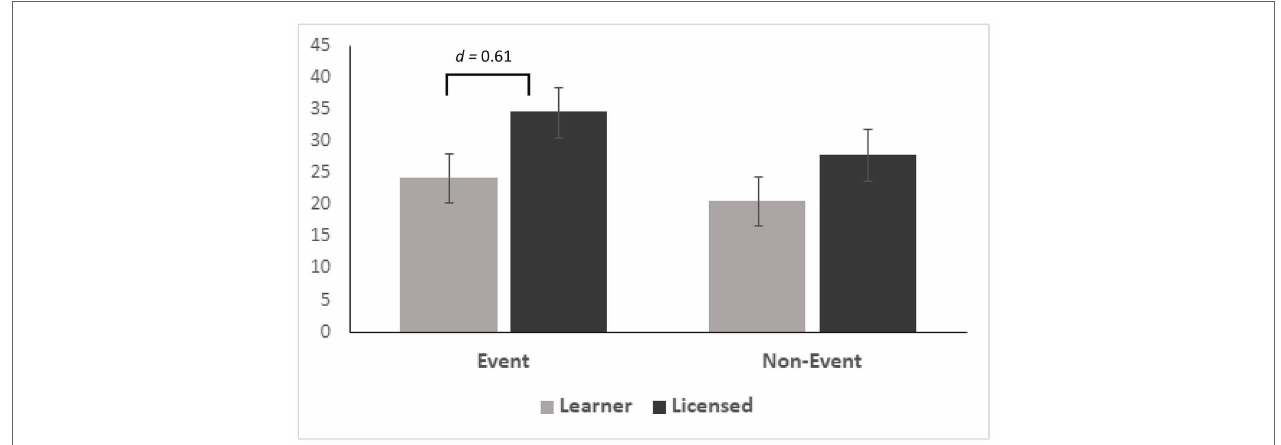
FIGURE 2 | Mean skin conductance response (SCR) score by Group and Video Type with SE